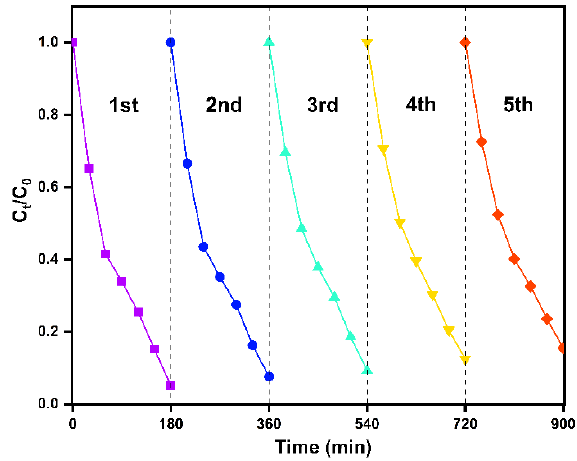
Figure 9. Reusability of photocatalytic activities experiment on 40SSO/CN photocatalyst.